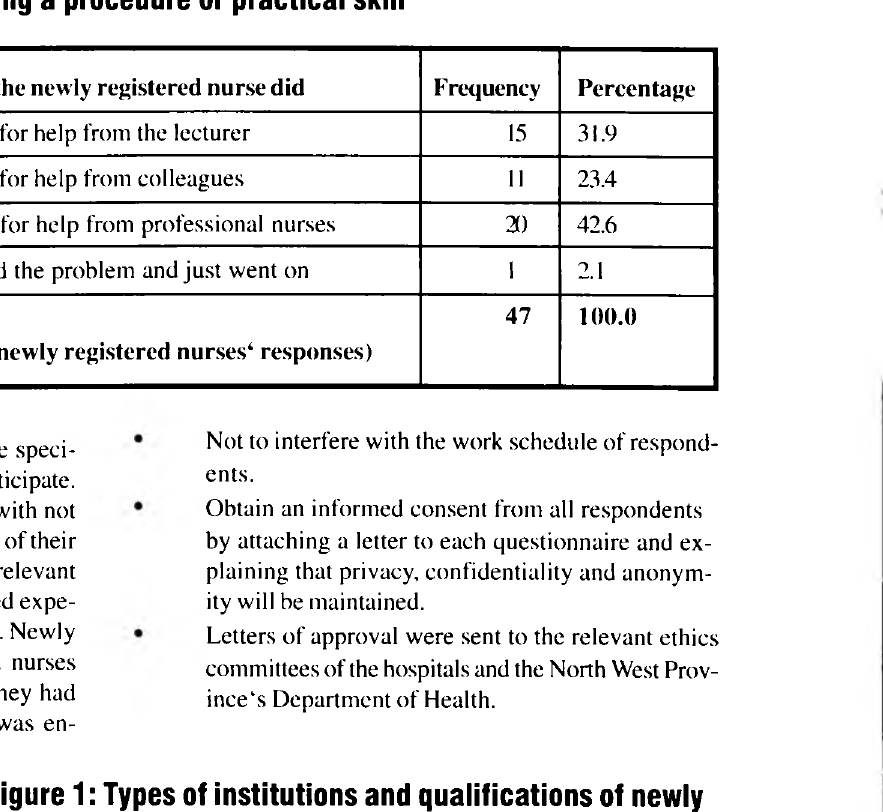
Figure 1: Types of institutions and qualifications of newly registered nurses